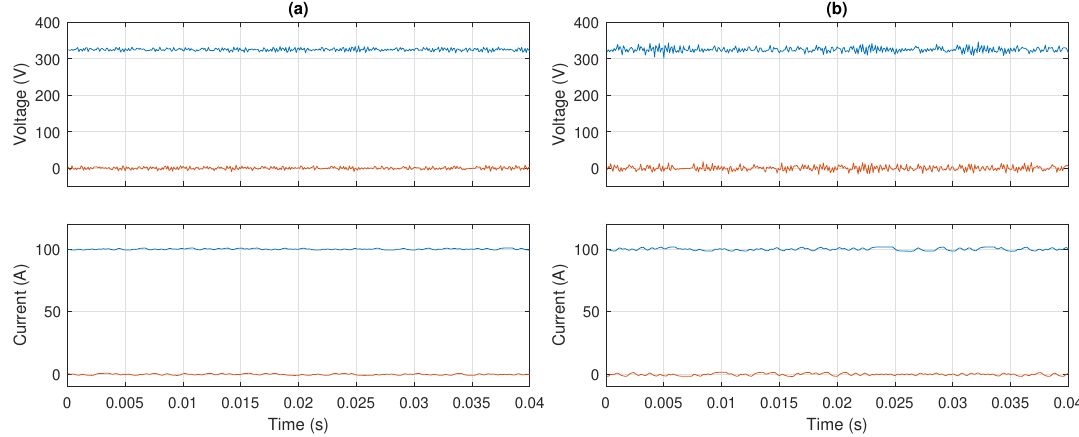
Figure 12. Dq-domain variables ( a ) without and ( b ) with the injection.